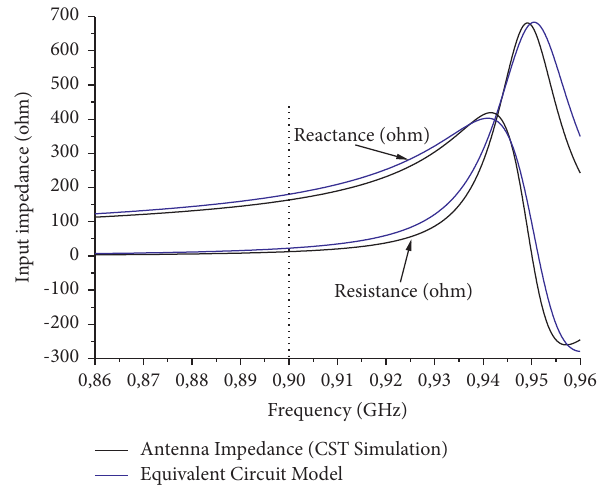
Figure 3: Simulated and modeled input impedances of the pro- posed 3D PILA tag antenna.